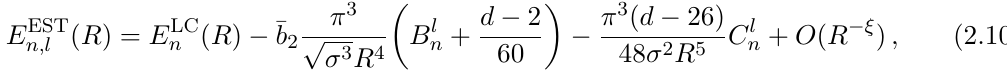
and C l appearing in eq. (2.10). ‘sym. tracel.’ n n